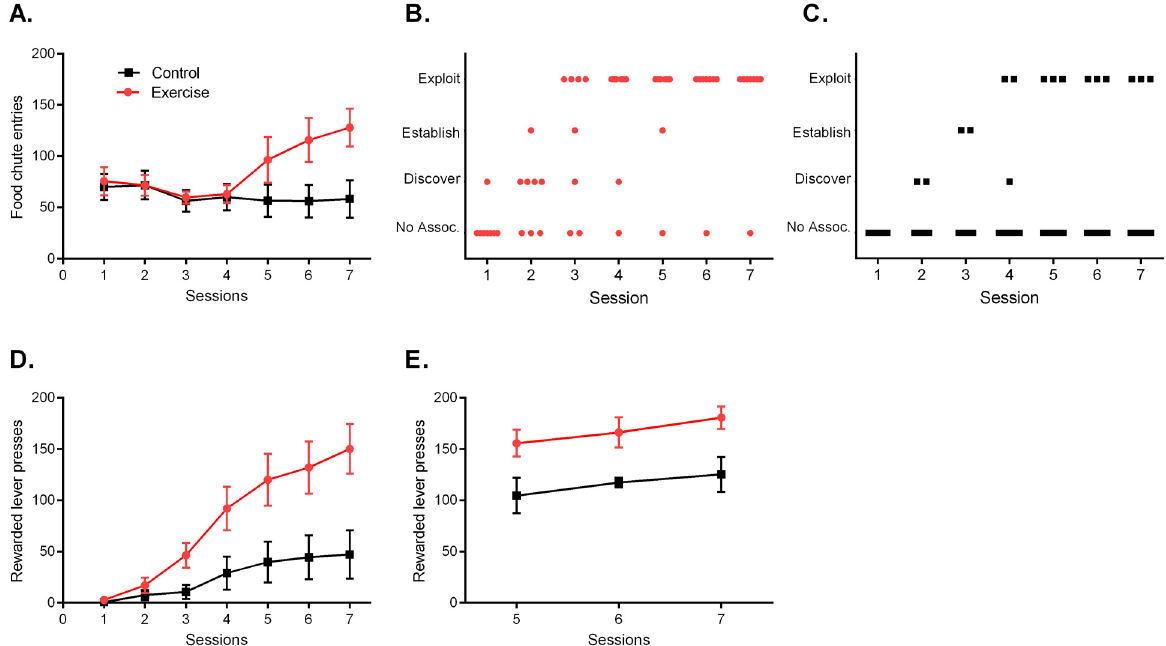
Fig 5. Operant Box Task. A) When given 15 min in the novel, levered scenario, both groups made multiple entries into the food chute, suggesting knowledge of reward location. B) Stage progression for the Exercise group; each rat is indicated as a dot for each session. C) Stage progression for the Control group; each rat is indicated as a square for each session. D) Across sessions, the Exercise group procured significantly more reward as compared to Control group. E) When comparing only rats who reached the exploitation stage for three consecutive sessions (n = 6 Exercise, n = 3 Control), the Exercise exploiters achieved more lever presses, and therefore more reward, per session. Data are shown as mean ± SEM; for each group in panels A-D, n =